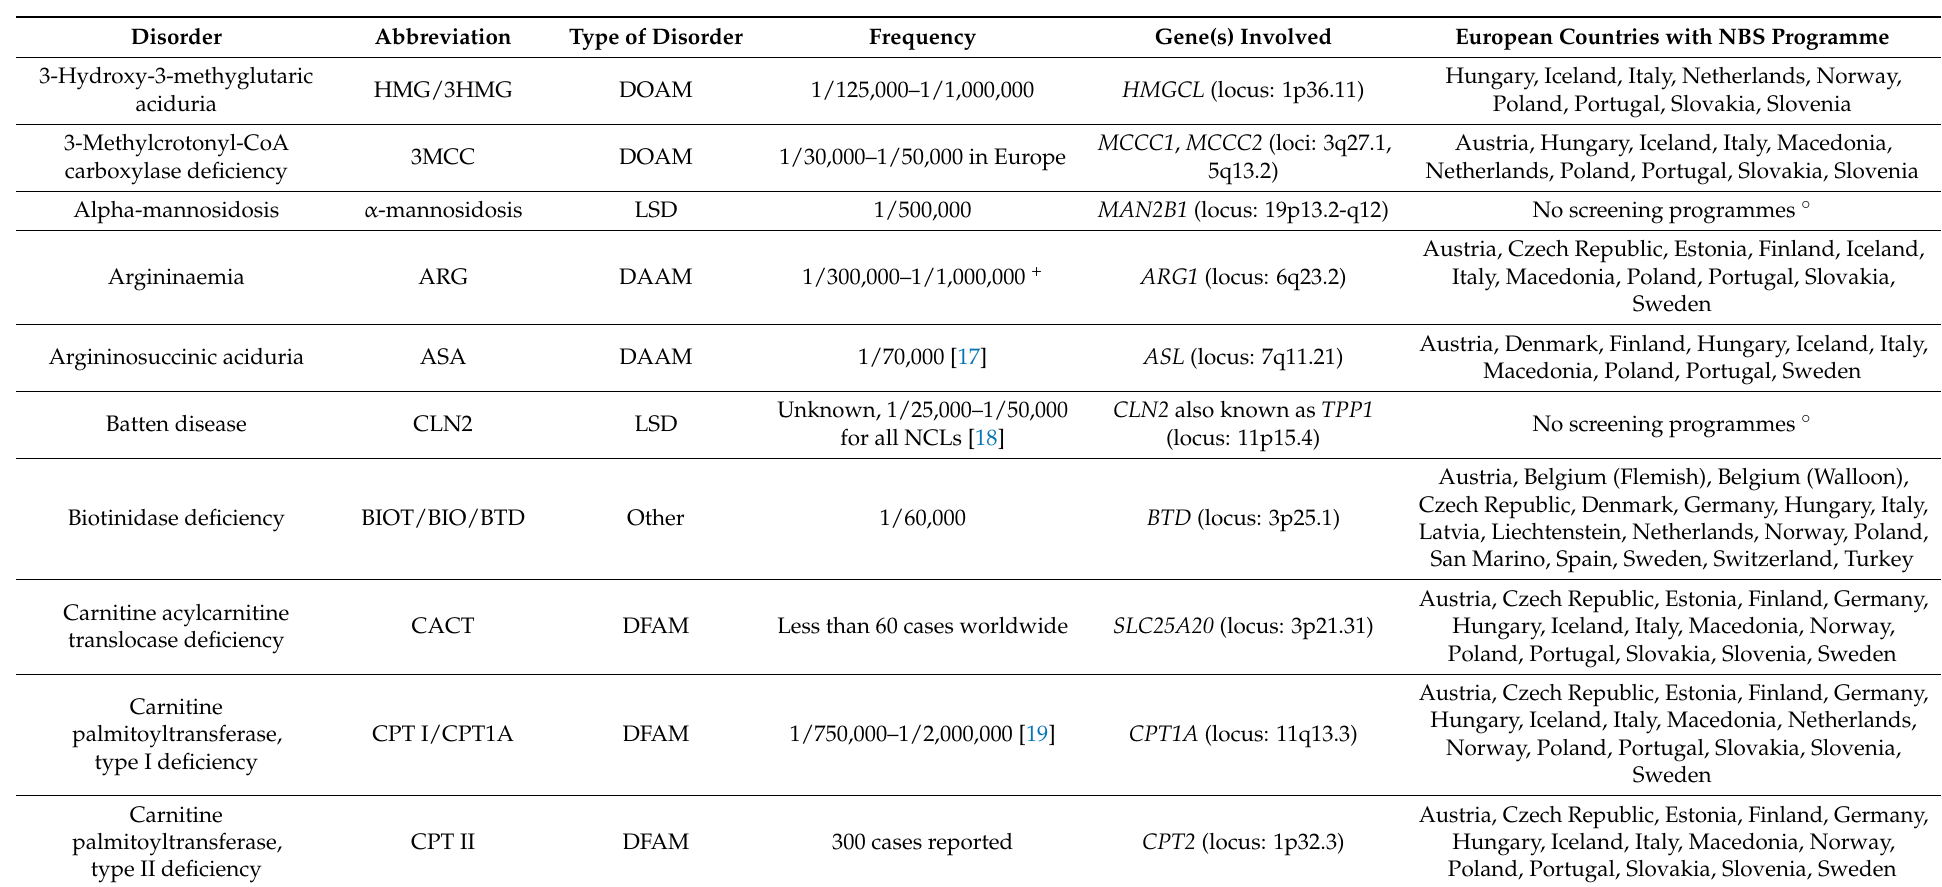
Table A1. Characteristics of IMDs identified for